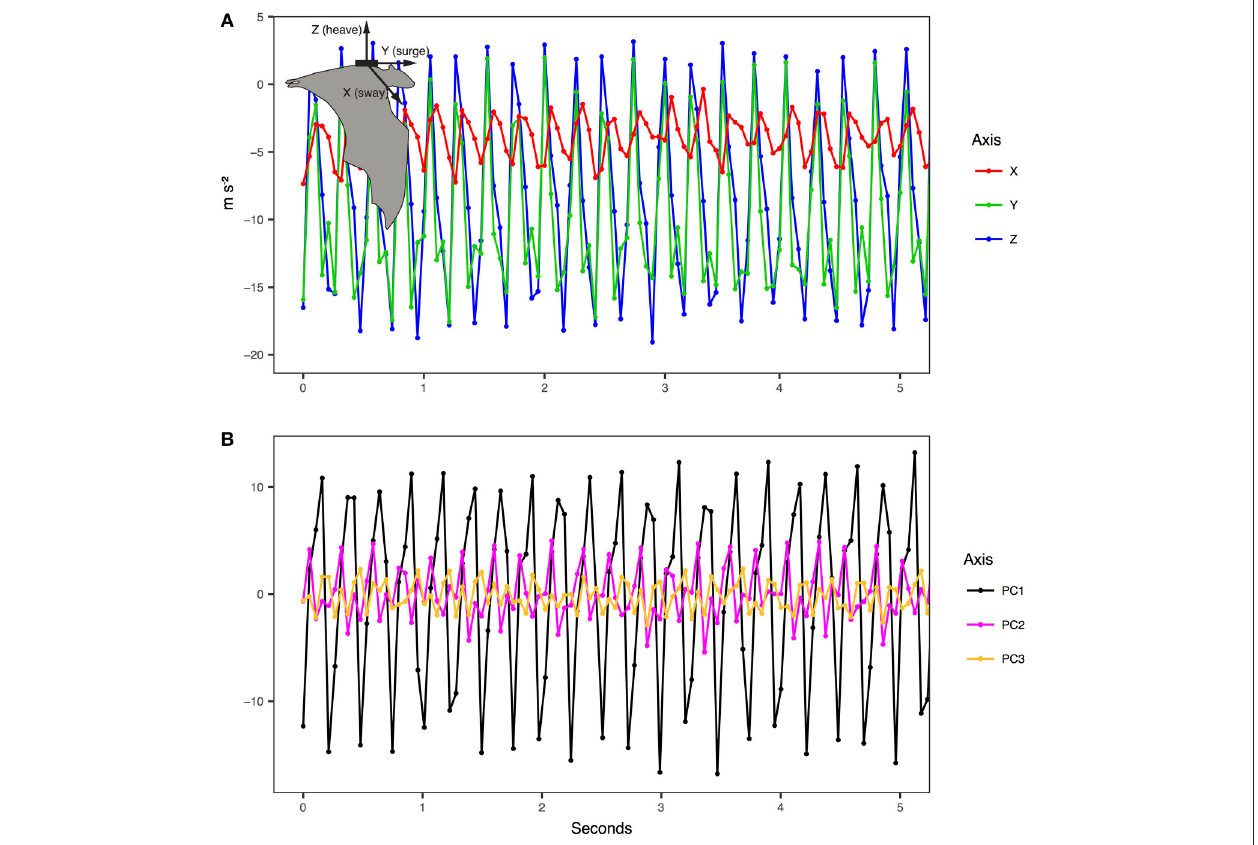
FIGURE 1 | Example of tri-axial accelerometry measurements and principal component conversion for E. helvum (inset). (A) The raw data were transformed according to manufacturer instructions into ms − 2 . (B) The principal components reflect the standardized major wave forms for the three axes for each burst of acceleration.